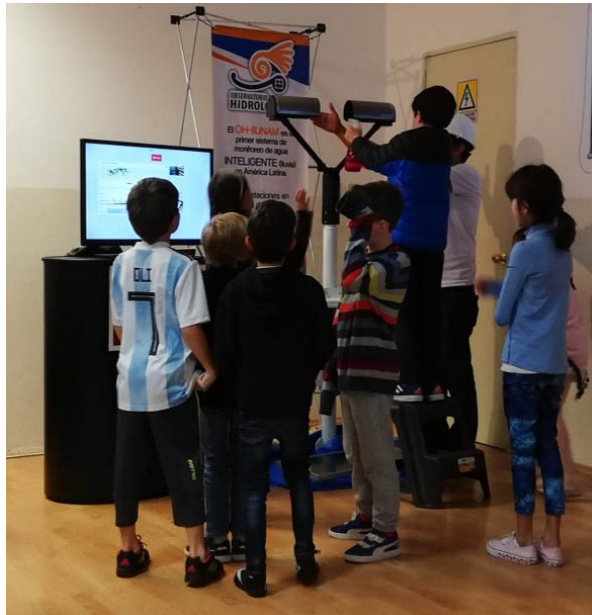
Figure 8. A group of students participating in the “meet and play with a real optical disdrometer”